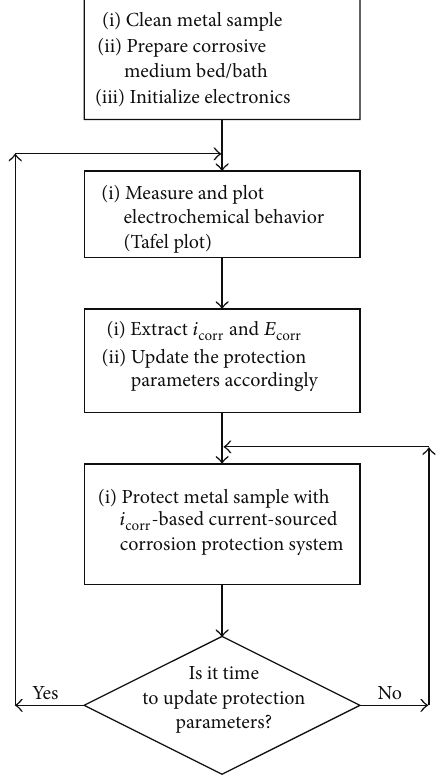
Figure 3: Flow chart of the proposed adaptive corrosion protection system